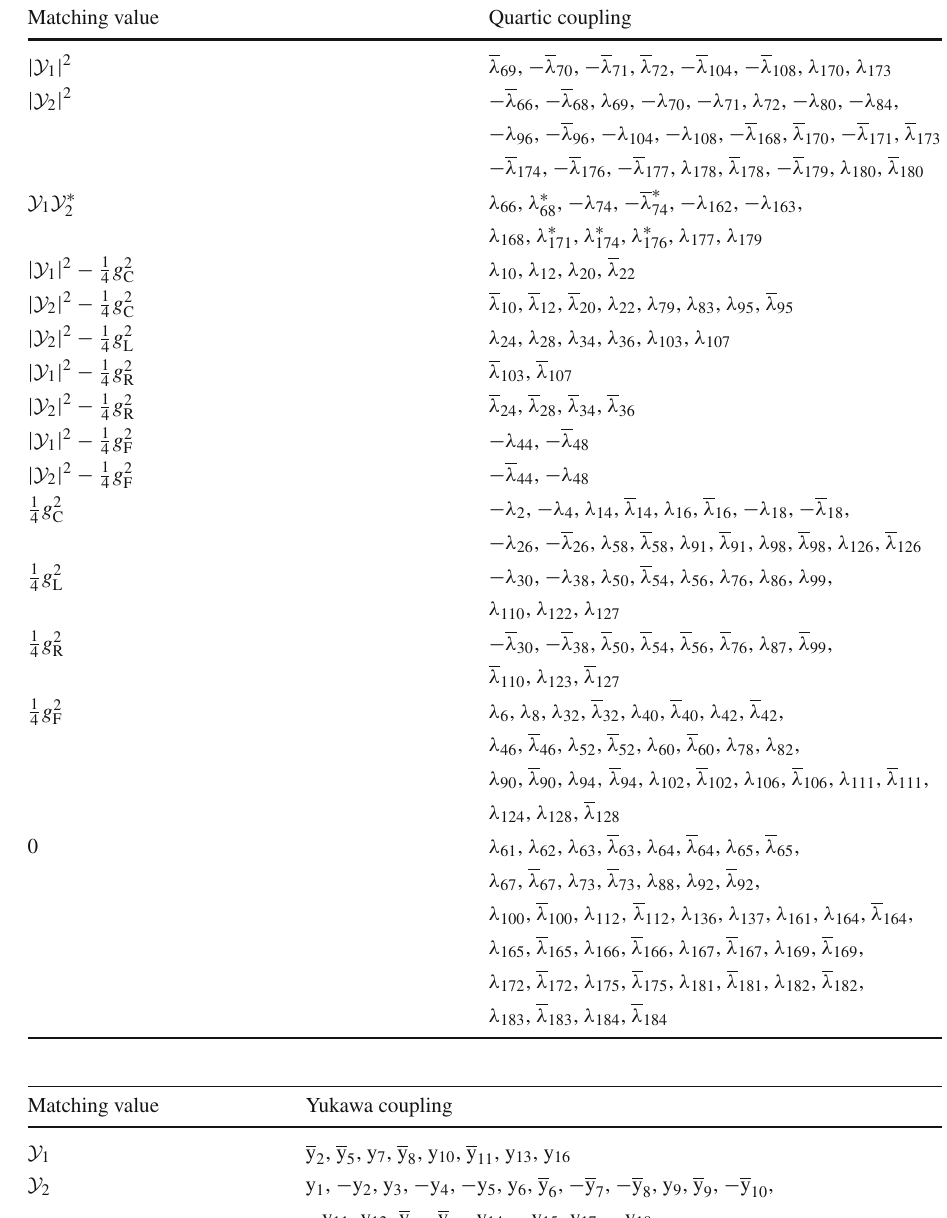
couplings matching conditions with one or zero D-term interactions. The λ i couplings refer to the ( L → R ) part of V 4